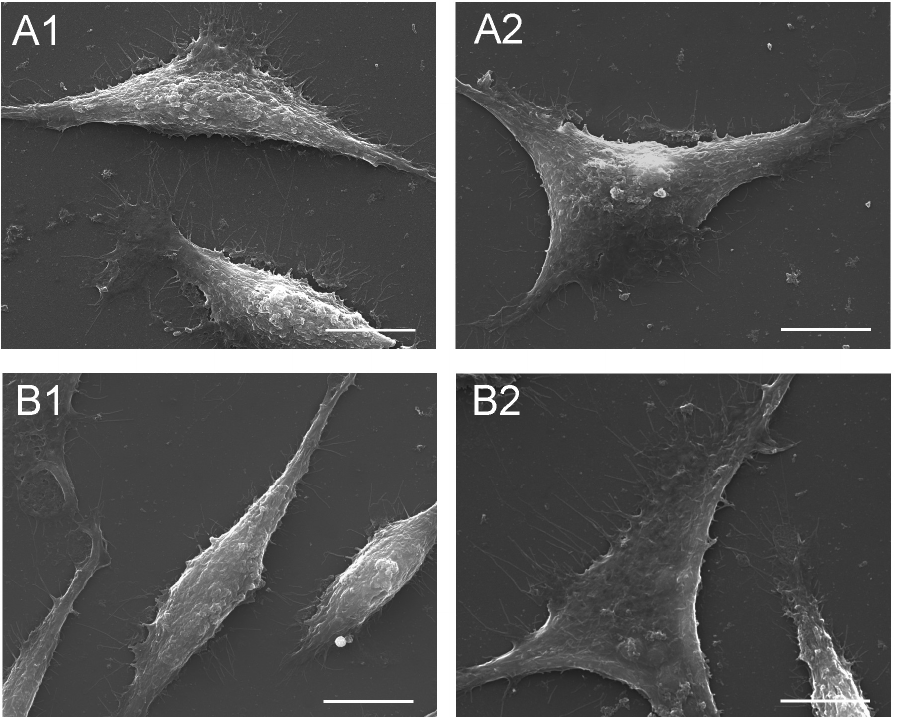
Figure 9. SEM imaging of fibroblasts: ( A1 , A2 )—control fibroblasts; ( B1 , B2 )—fibroblasts incubated with the S. hermaphrodita protein seed extract at a concentration of 100 µg/mL. The scale bar corre- sponds to 50 µm. Table 1. Elemental composition of S. hermaphrodita seed extract determined after excitation of the preparation with a 10 kV beam. Wt%—weight percentage of a given element in the sample; At%— atomic percentage of a given element in the sample. The results presented are the mean of three independent